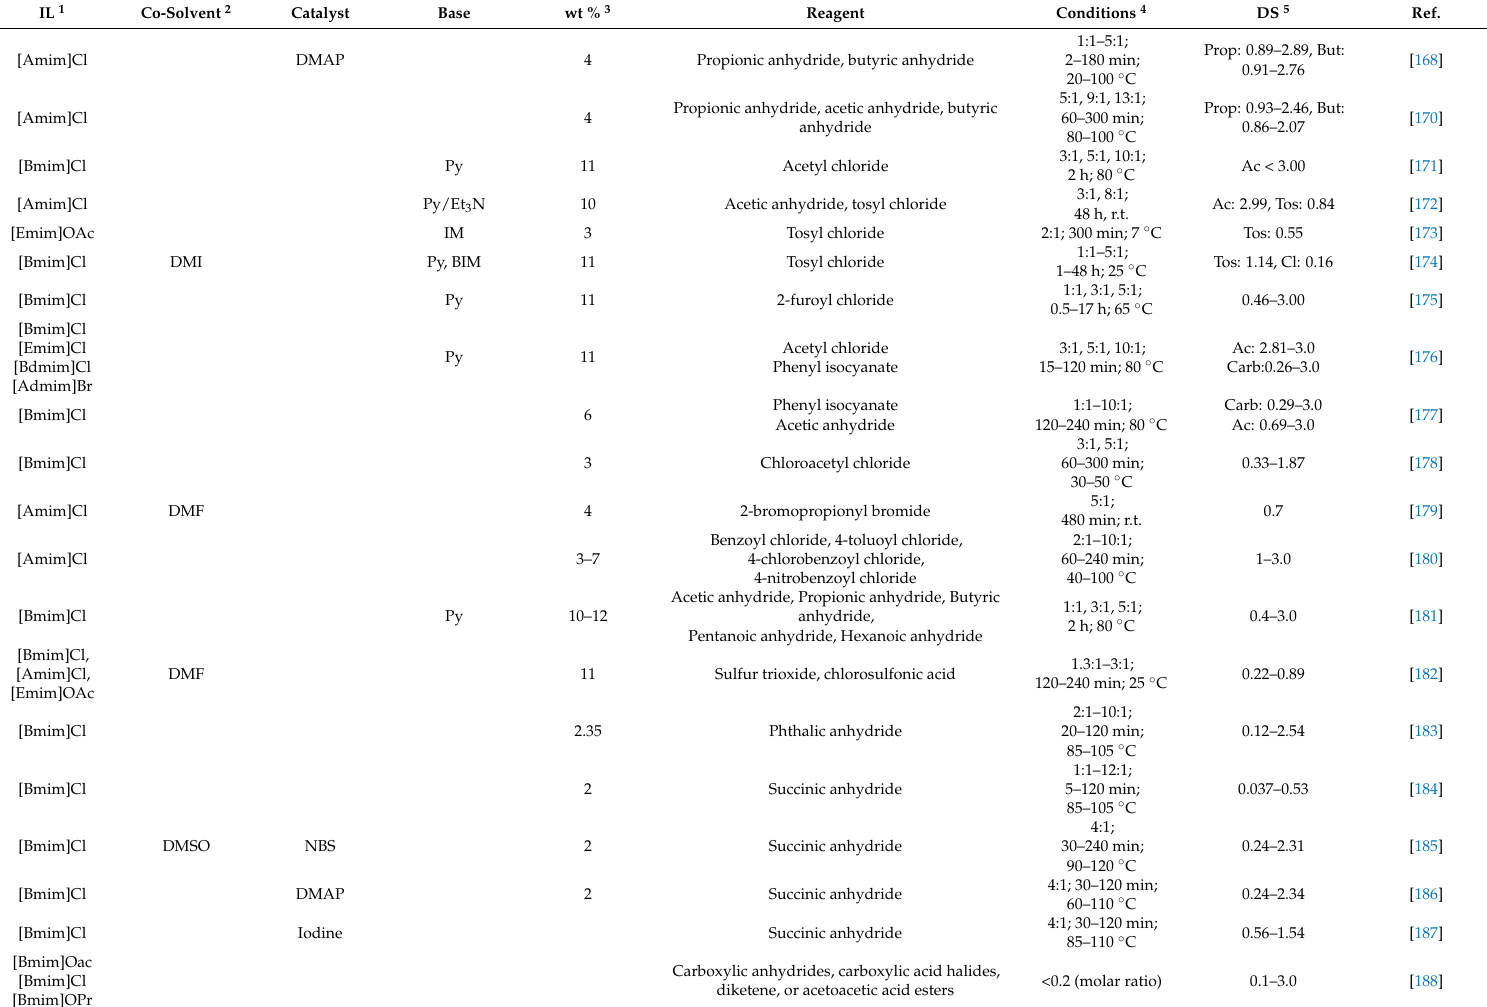
Table 4. Conditions of reaction media for the homogeneous esterification of cellulose and DS of the cellulose derivatives. IL